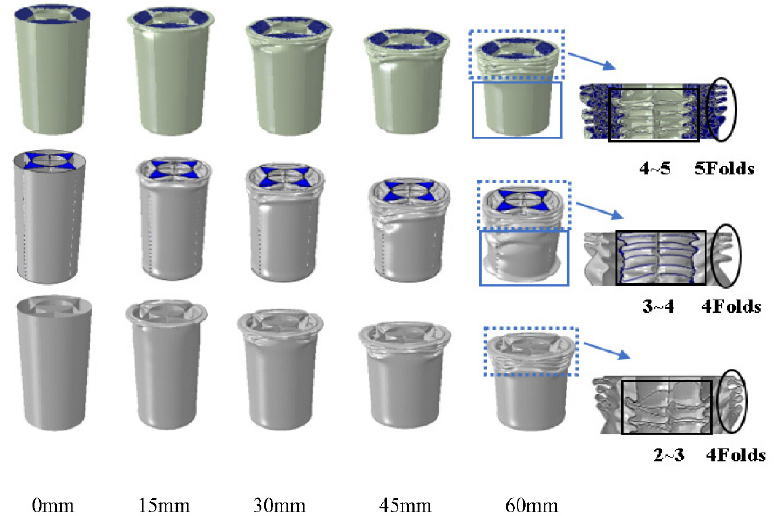
Figure 7. Deformation mode of filling structure.